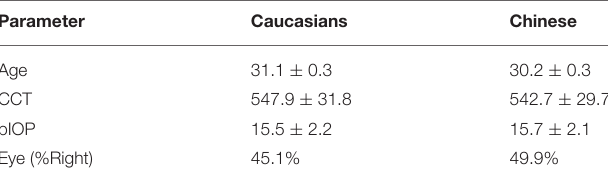
TABLE 1 | Baseline and demographic data of the study